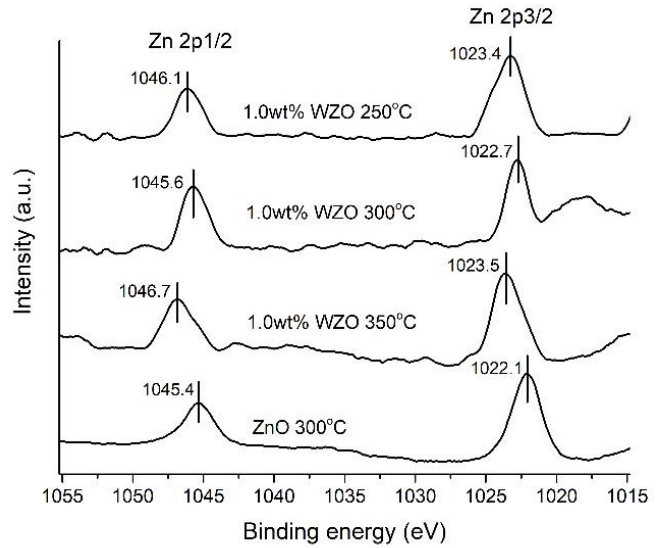
Figure 14. Zn 2p1/2 and Zn 2p3/2 peak intensities of 1.0 wt.% WZO films grown at 250 °C, 300 °C, and 350 °C, and ZnO film grown at 300 °C.